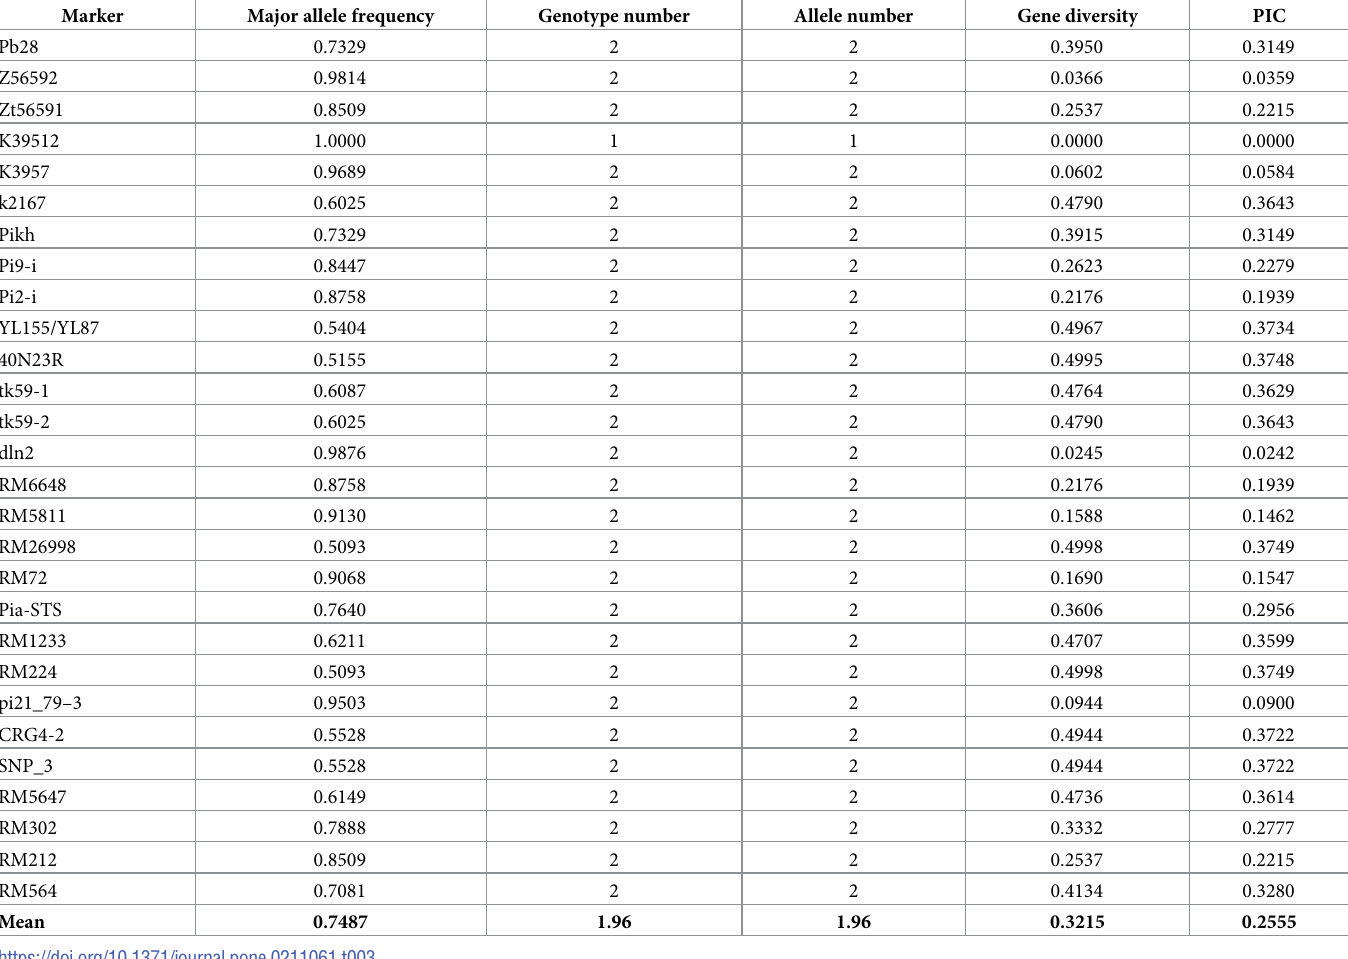
Table 3. Estimation of major allele frequency, genotype number, allele number, gene diversity and PIC in landraces.